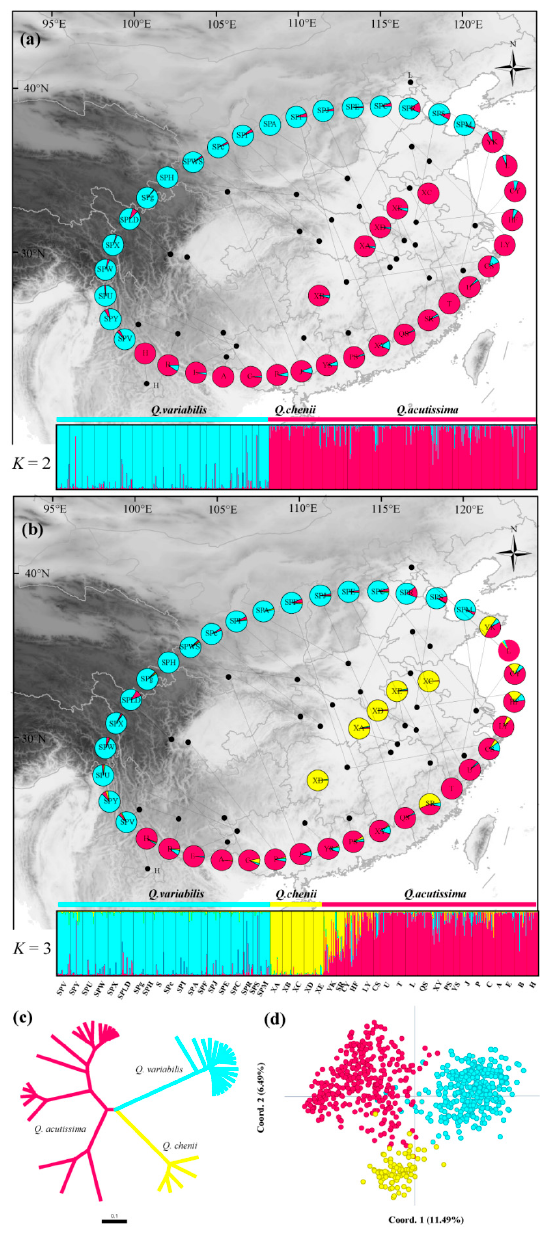
Figure 1. Structure analysis results and genetic composition of each population in three Cerris oaks. The K = 2 ( a ) and K = 3 ( b ) clusters were shown. The unweighted pair-group method using arithmetic averages (UPGMA) dendrogram using Nei’s (1972) distance ( D s) of 44 populations ( c ) and principal coordinates analysis (PCoA) of 759 individuals of three Cerris oaks ( d ).